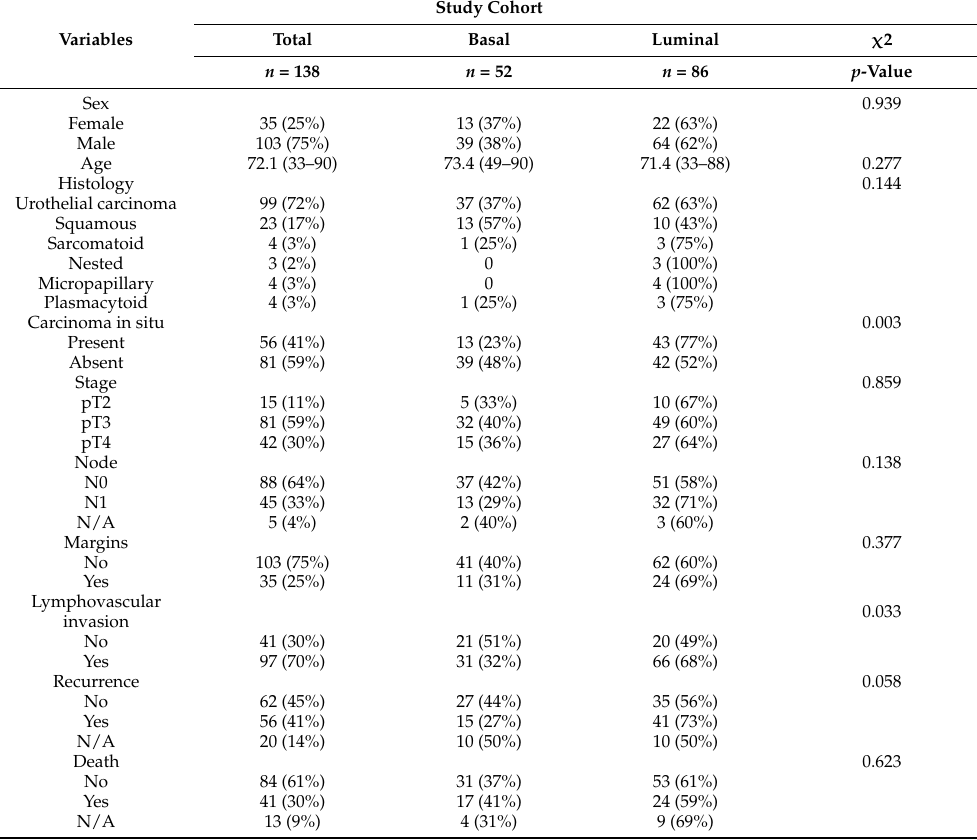
Table 2. Relationship between molecular subtypes and clinicopathological parameters of 138 muscle- invasive bladder cancers included in the